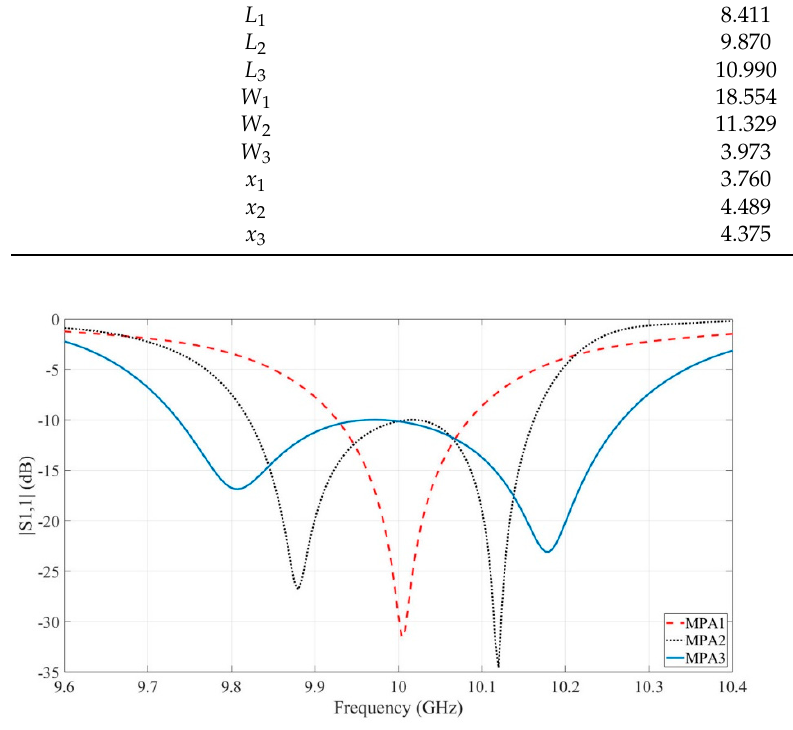
Figure 7. MPA3 configuration.